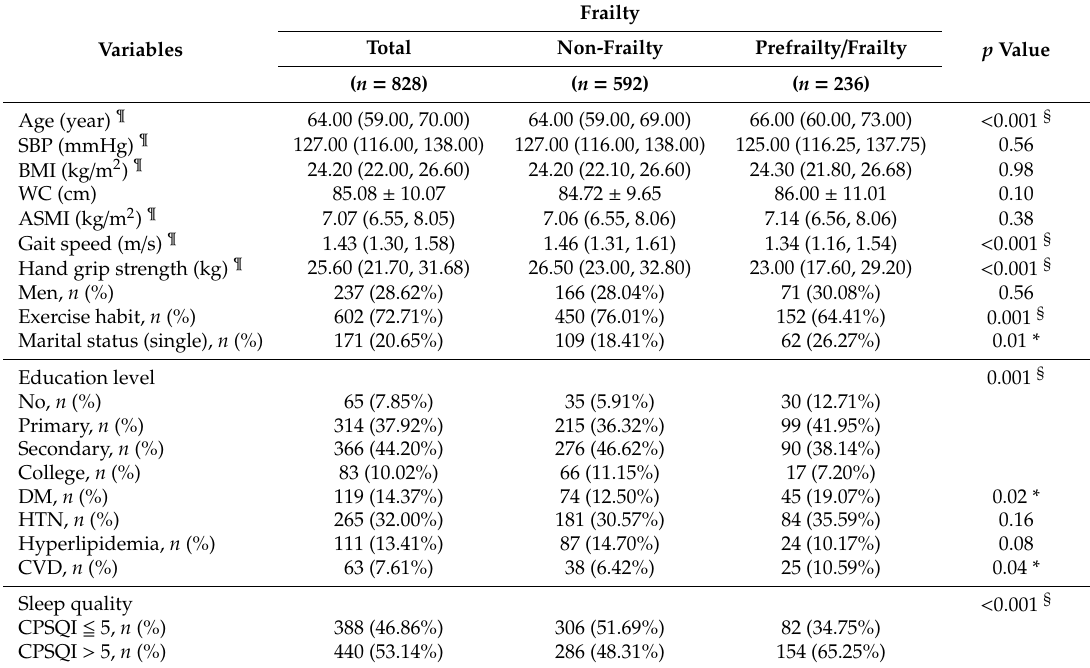
Table 2. General characteristics of the study population according to frailty status.